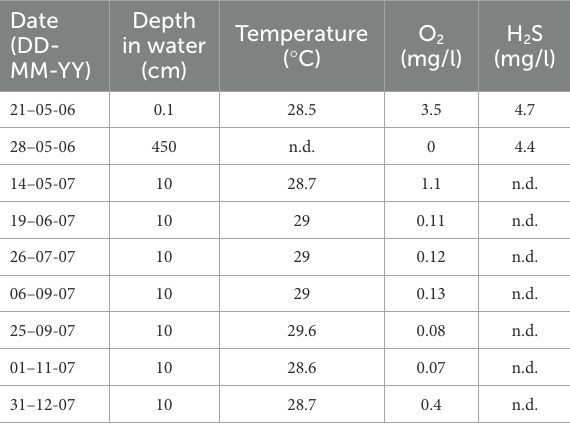
TABLE 1 Temperature, oxygen and hydrogen sulfide in Ayyalon Cave groundwater pond at various depths and